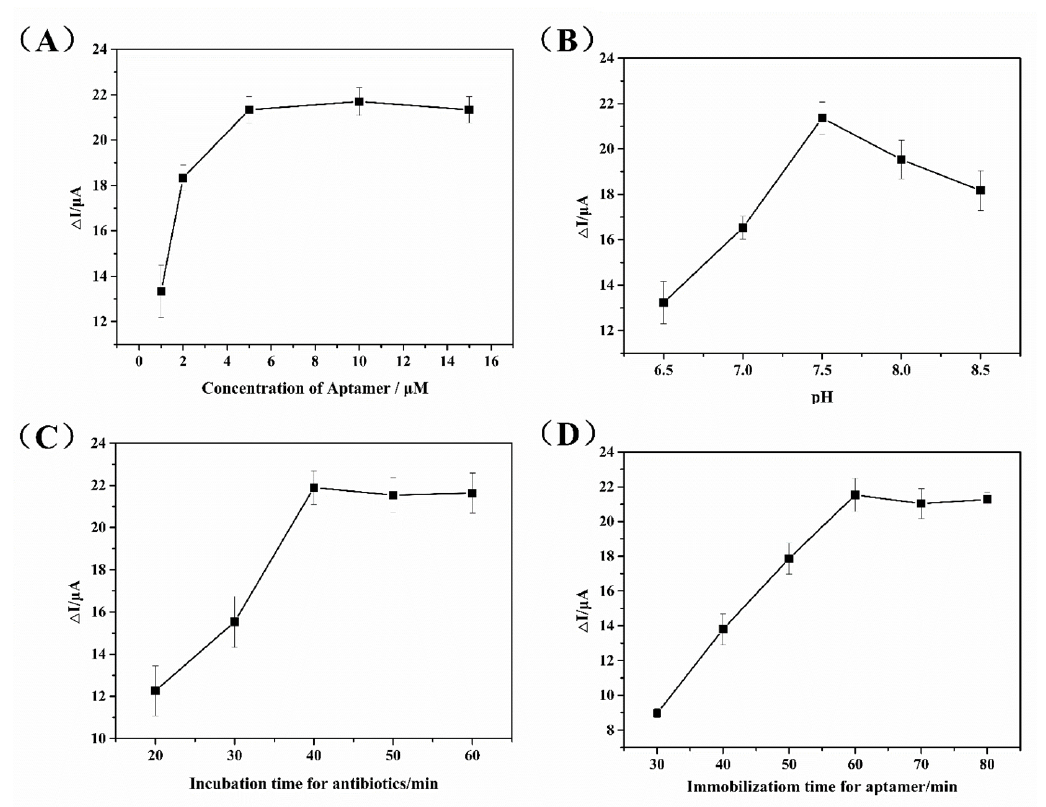
Figure 4. Optimization of experimental conditions: ( A ) aptamer concentration; ( B ) pH; ( C ) incubation time for antibiotics; ( D ) immobilization time for aptamer.